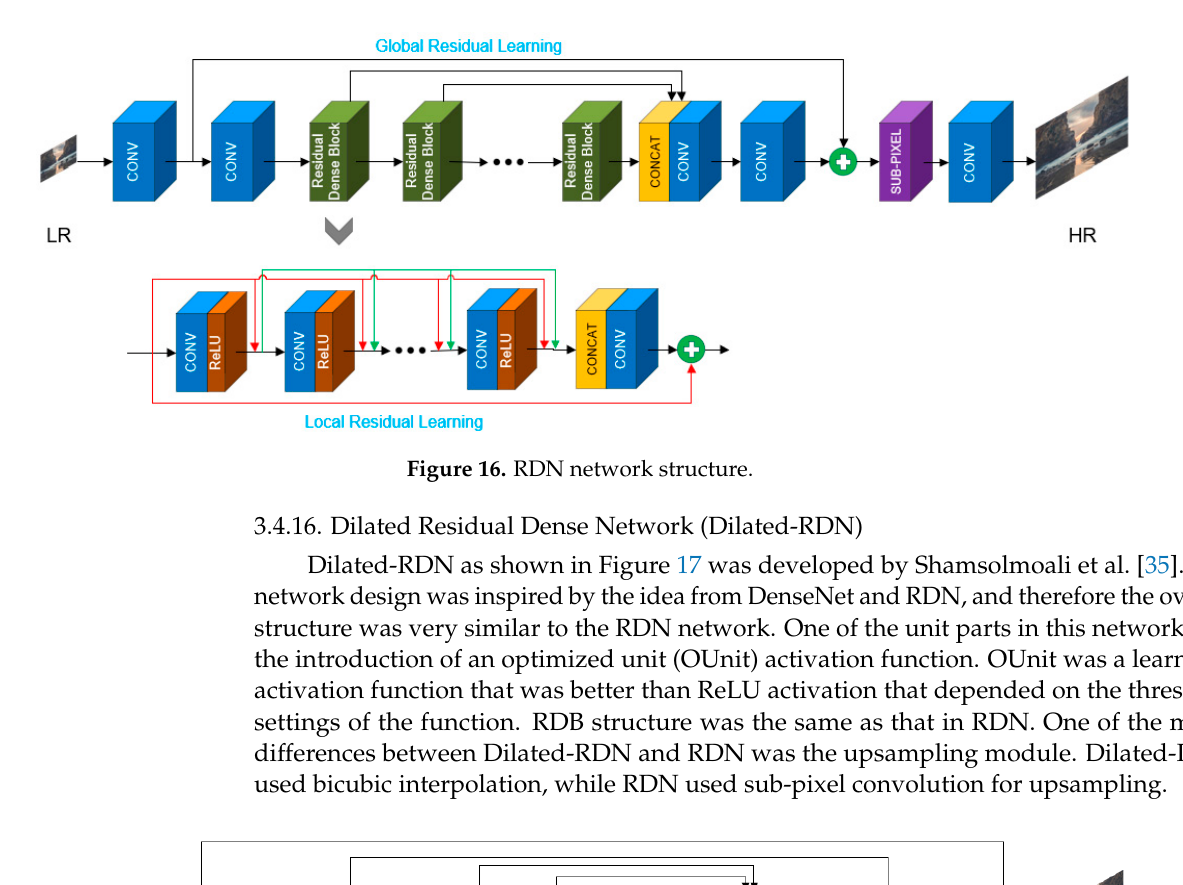
18 of 33 Figure 15. SRDenseNet network structure. SRDenseNet improved the PSNR value by about 4.3% when compared to SRCNN. The model also improved the PSNR value by 2.0% when compared to VDSR and DRCN. Therefore, the adoption of dense connection in dense blocks significantly showed that it was able to solve the gradient vanishing problem, which often happens when the network becomes deeper. Besides, the adoption of the deconvolutional layer also helped in im- proving the reconstruction process since the layers are able to learn the upscaling filters. 3.4.15. Residual Dense Network (RDN) SRDenseNet still had a minor disadvantage, although it performed well compared to SRCNN, VDSR, and DRCN. The disadvantage was that the mode will be hard to train when it got wider with dense blocks. Thus, RDN [40] was proposed, with its network design shown in Figure 16. In RDN, residual dense block (RDB) was used instead of DB. Other than dense connection, residual learning is also adopted within RDB. The residual learning in RDB is also known as local residual learning. Other than that, the intermediate output from each RDB was fused through concatenation before global residual learning